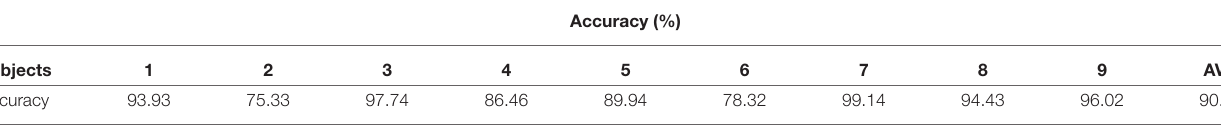
TABLE 6 | Results of inter-subject transfer learning classification using the BCIIV2a dataset.